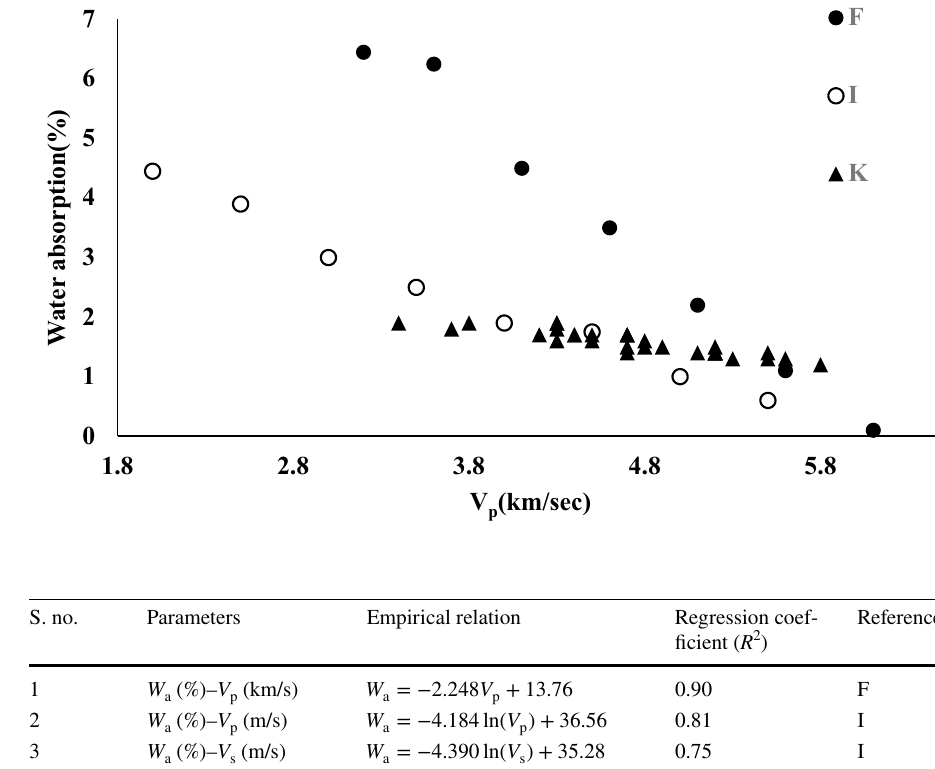
Fig. 7 V p versus water absorp- tion as reported by different researchers